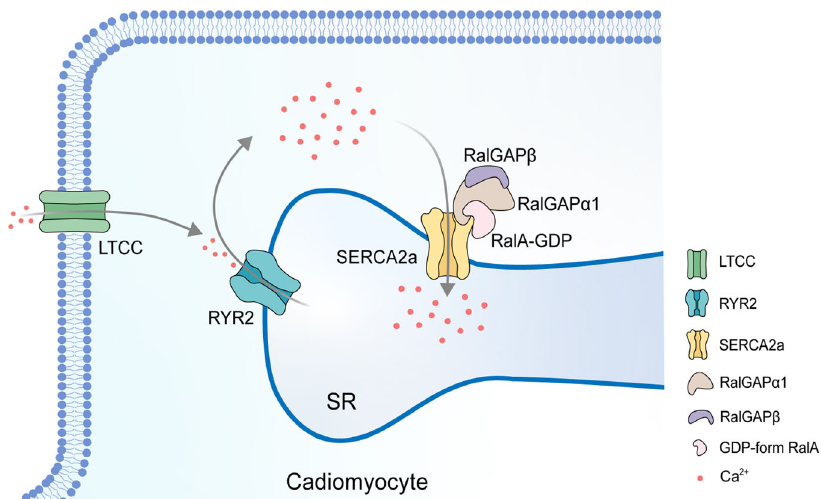
Fig. 7 | A model for the RalGAP α 1 − RalAsignal moduleas a critical regulator of SERCA2a. Adiagrammaticillustrationrepresentstheproposedmodelinwhichthe RalGAP α 1 − RalA signal module regulates Ca 2+ homeostasis in cardiomyocytes via interacting with SERCA2a. GDP-bound RalA interacts with SERCA2a, and